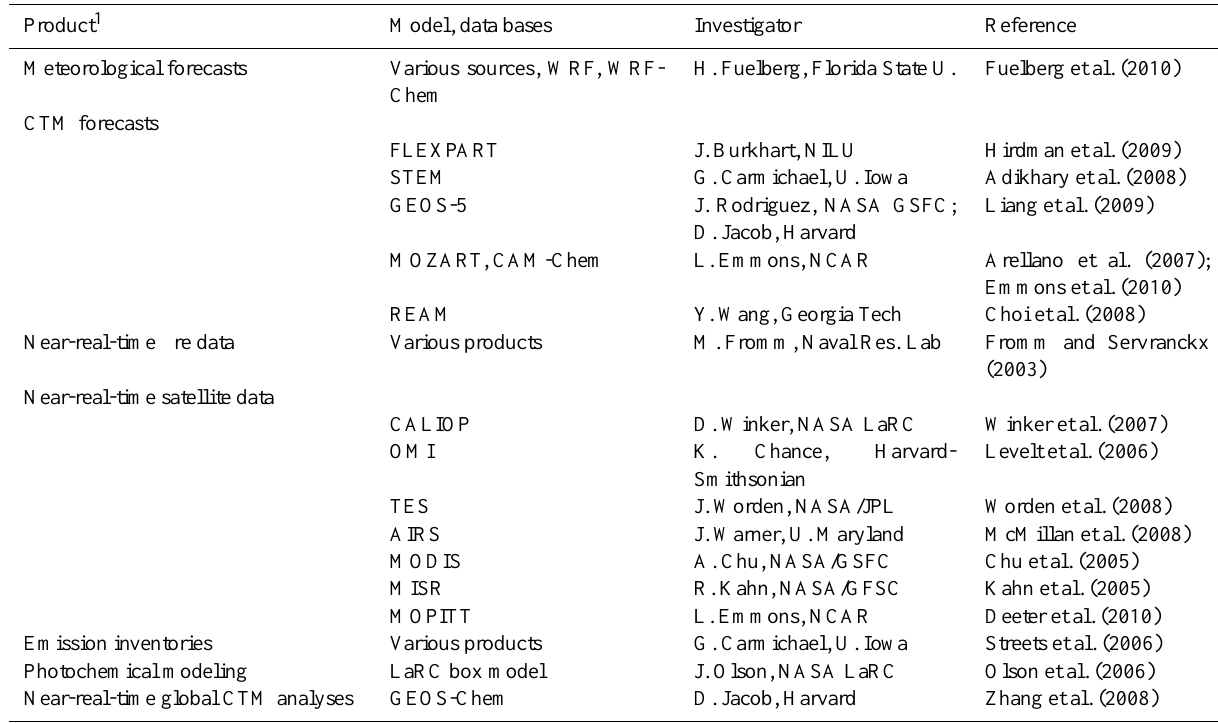
Table 3f. Supporting investigations during ARCTAS.